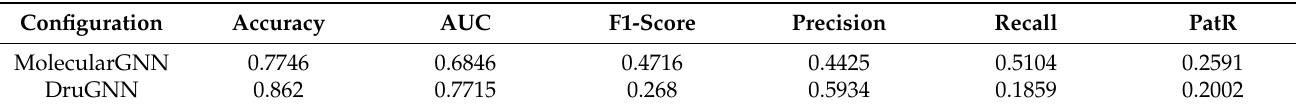
Table 2. Comparison of MolecularGNN and DruGNN.